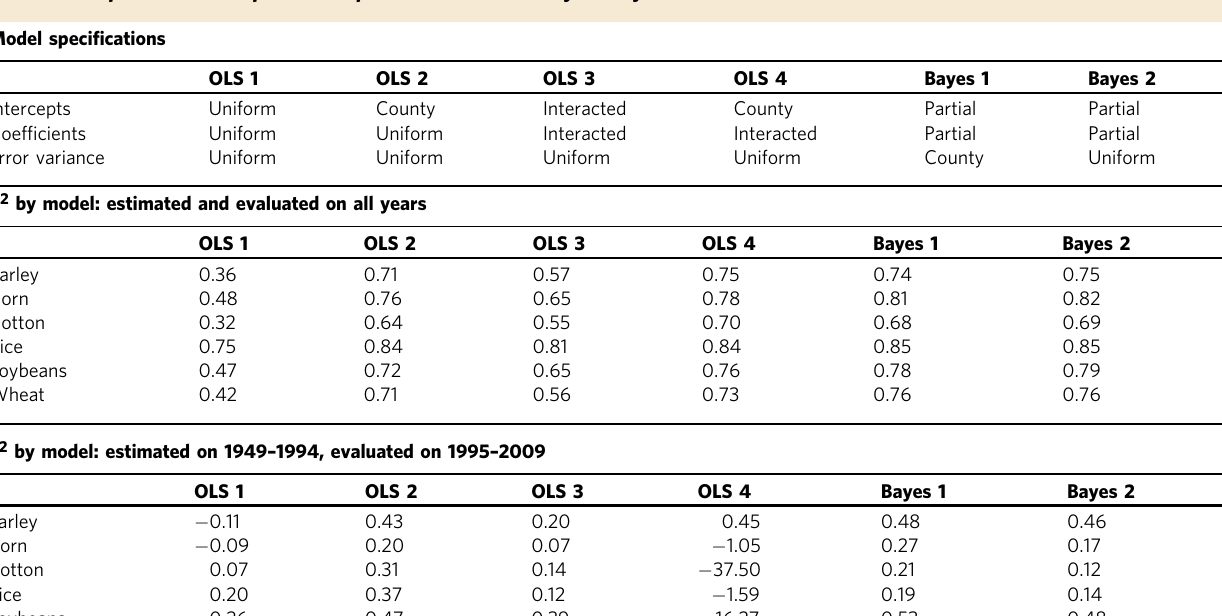
P y i (cid:2) ^ y i ð Þ 2 P , where y i is the observed log yield for county-year i . ^ y i is the point estimate for y i (cid:2) (cid:2) y i ð Þ 2